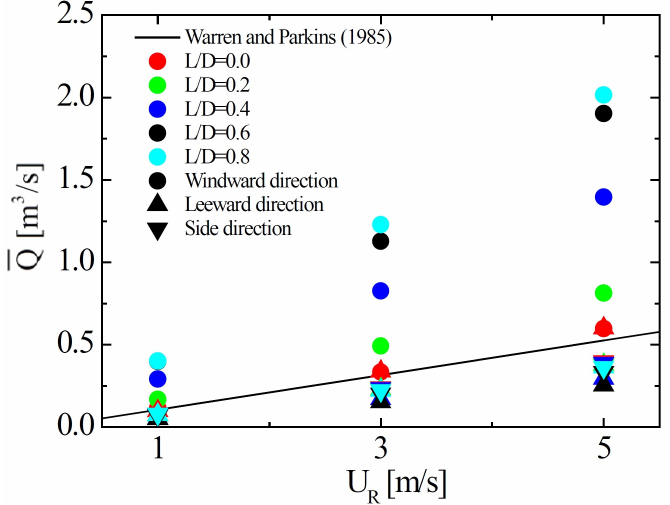
Figure 6. Comparison of the present ventilation rates with the correlation of Warren and Parkins